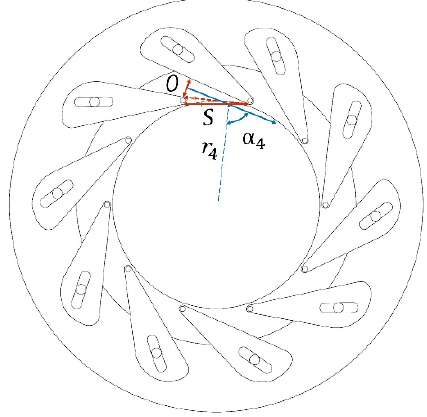
Figure 6. Typical variable-geometry guide vanes for radial turbines.